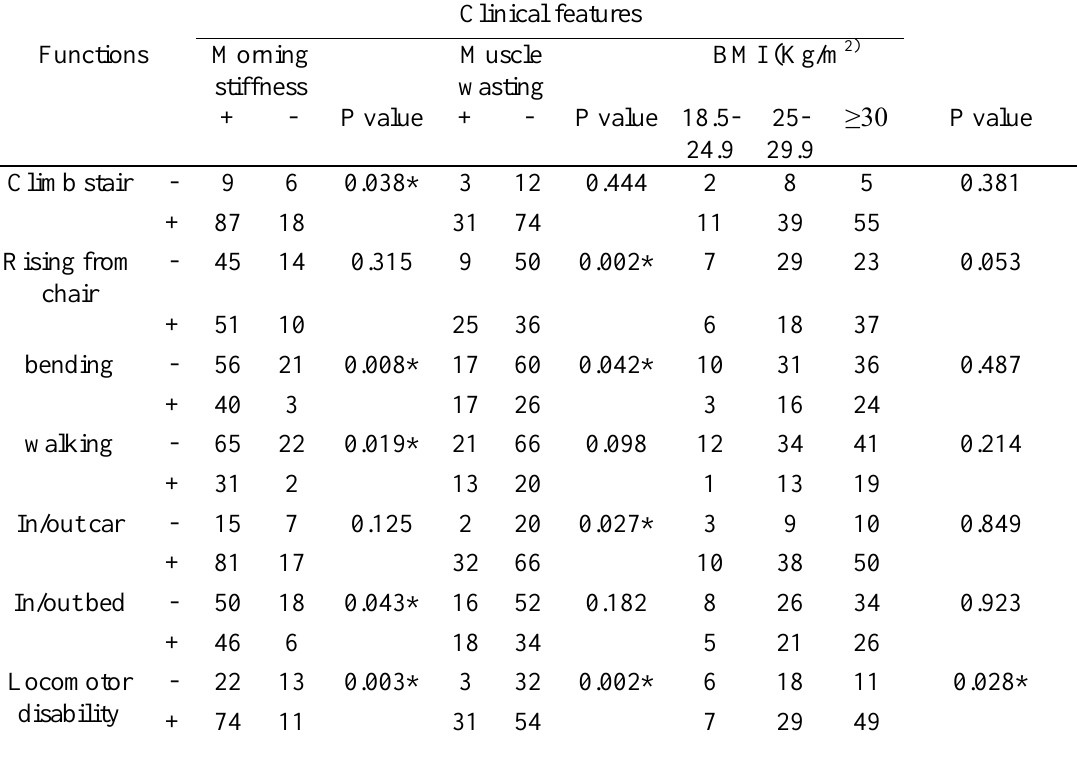
Table 2: Distribution of clinical features according to disability in the six separate locomotor functions of the lower limb in 120 knee osteoarthritis